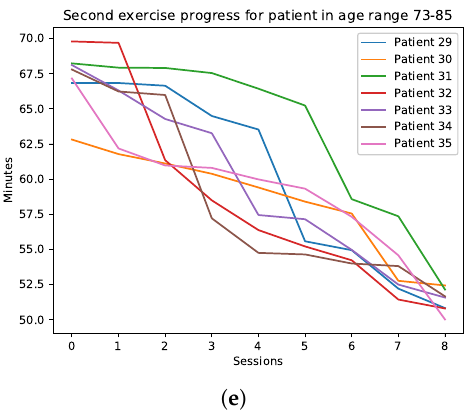
Figure 12. The performance of the patients for the second exercise. The plots are divided by age: